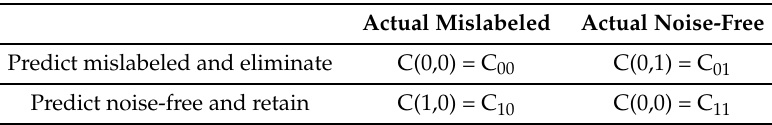
Table 1. Cost matrix of the mislabeled data